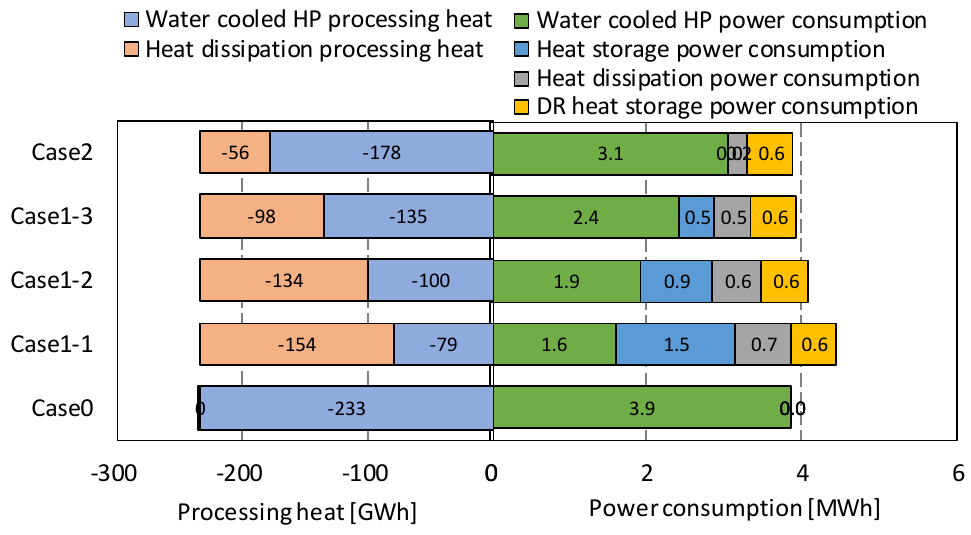
Figure 13. Processing heat and power consumption.